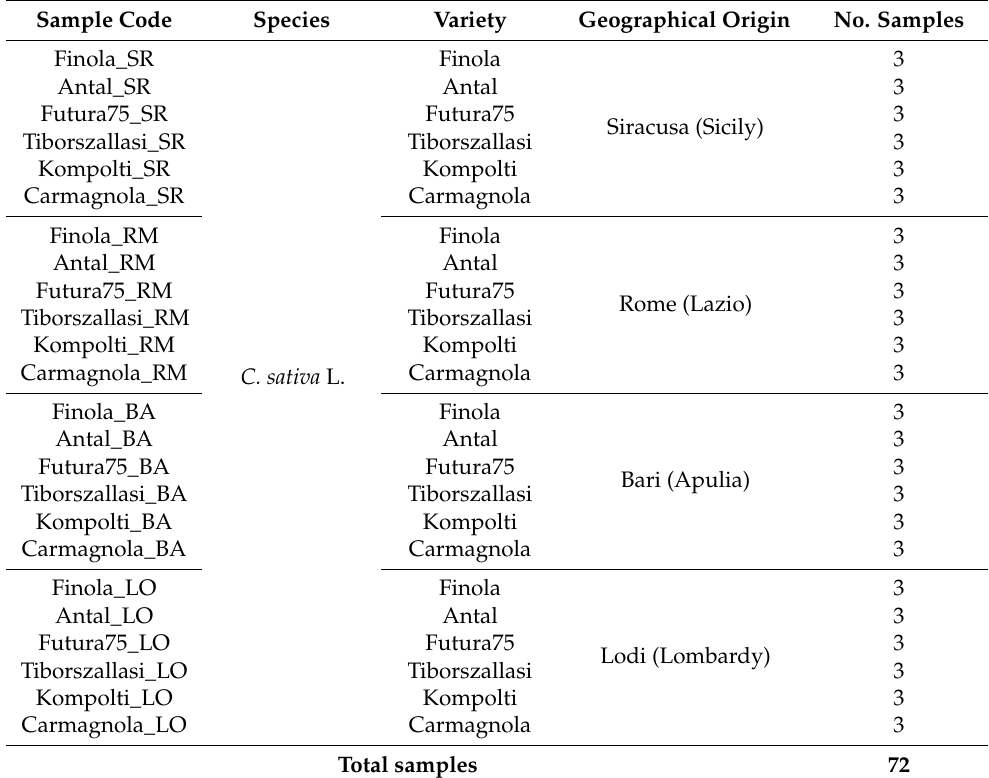
Table 1. List of the inflorescence samples collected for the present